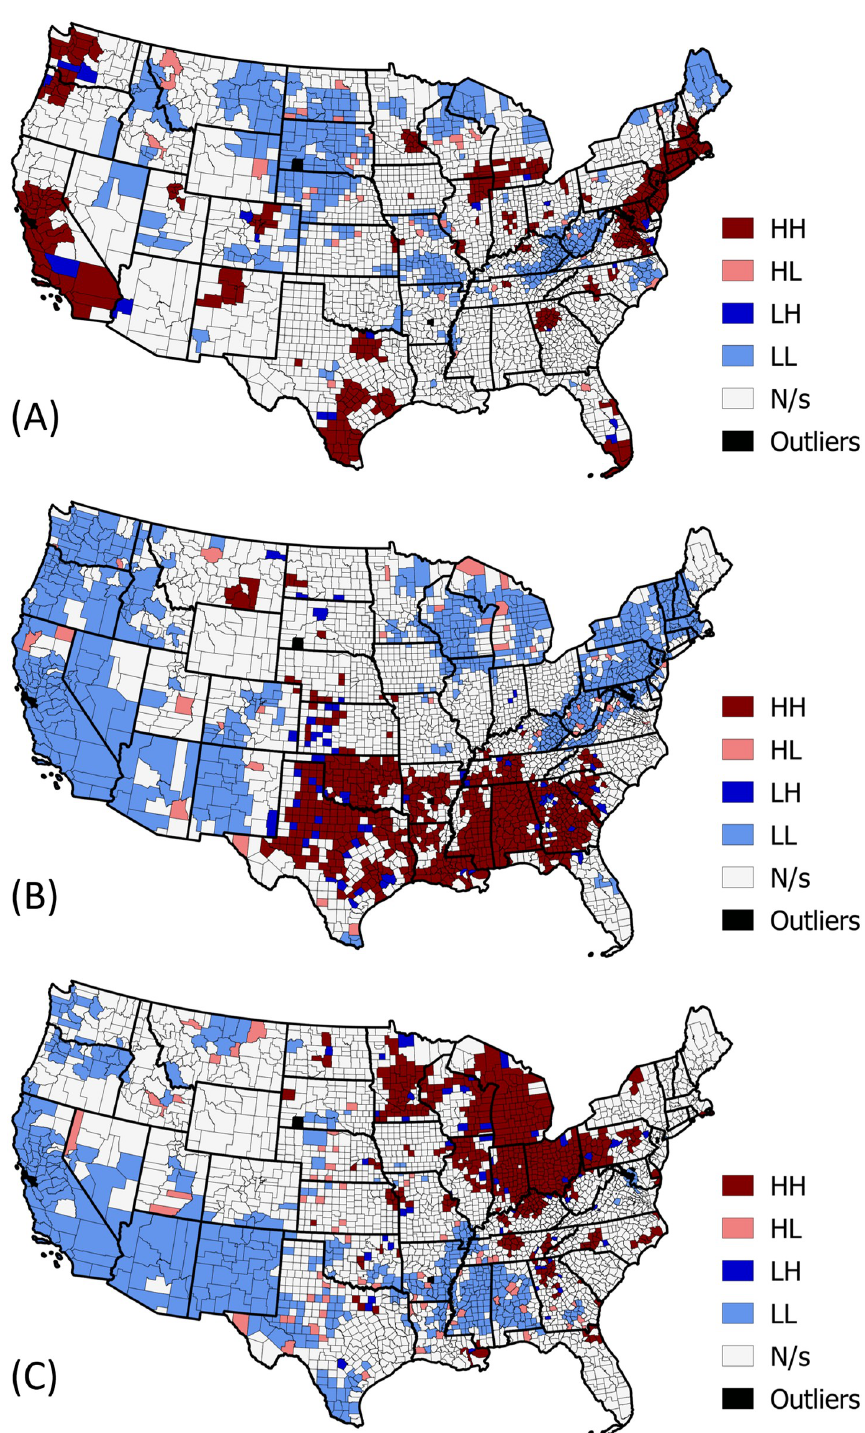
Fig 9. Anselin’s Local Moran’s I (LISA) results. (A) LISA for PC1. (B) LISA for PC2. (C) LISA for PC3. Maps produced in QGIS [30] using SafeGraph [3] derived data, shapefiles from data.gov [31].